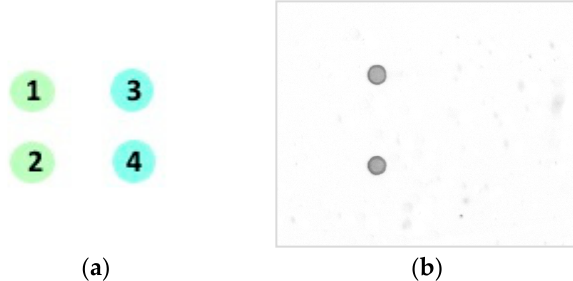
Figure 5. ( a ) Array layout: spots 1 and 2 correspond to gluten printed at 1 mg/mL and spots 3 and 4 correspond to ovalbumin spots printed at 1 mg/mL; ( b ) Colorimetric image of a processed microarrray spots after incubating with 1 ppm of gluten and developing for 3 min with TMB. Left spots corresponding to gluten spots whereas position of ovalbumin spots (negative control) rendering no signal are marked with a discontinuous circle on the right.